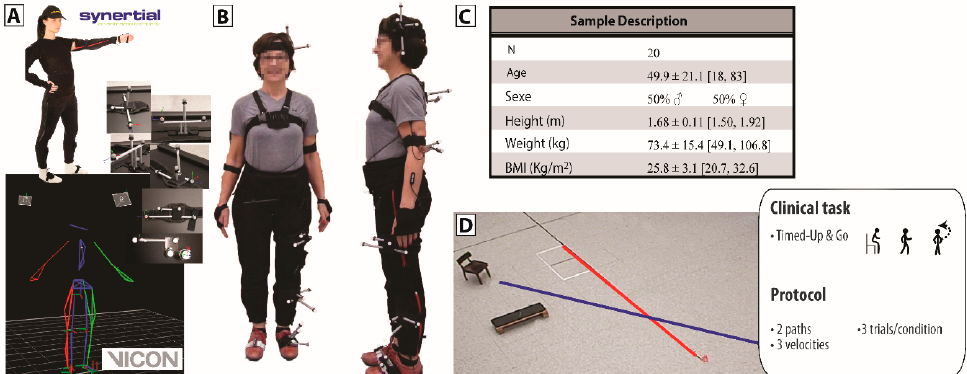
Figure 3. Setup and protocol. Joint accuracy validation is accomplished by comparison of the orientation data estimated by the AHRS with those obtained from an optical motion capture gold standard, VICON. ( A ) A subset of the AHRS is solidly affixed to a rigid body created with a minimum of four optical markers; ( B ) The assembled bundles are then placed on the body segments targeted for evaluation, namely the head, the upper trunk, the pelvis, and the left lower limb (thigh, shank, foot); ( C ) Twenty participants with a variety of anthropometric characteristics participated in this study, ensuring diverse conditions of realization of the tasks; ( D ) Participants were asked to perform a 5 m standardized timed-up and go (TUG), a recognized clinical test including a number of basic mobility tasks. Tests were performed along two different paths and at different velocities.